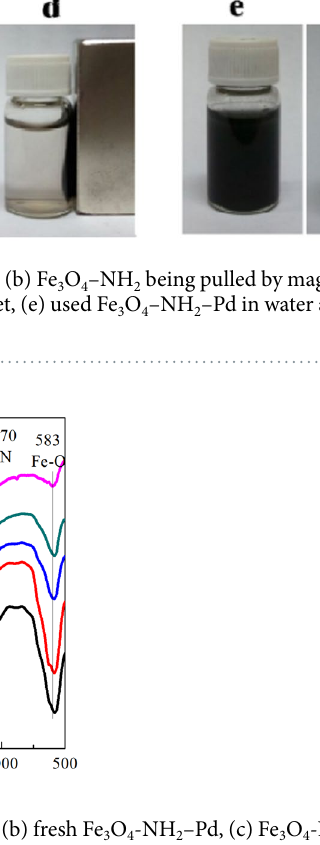
Figure 6. FT-IR spectra of (a) fresh Fe 3 O 4 -NH 2 , (b) fresh Fe 3 O 4 -NH 2 –Pd, (c) Fe 3 O 4 -NH 2 after Hg 0 removal at 100 °C, (d)